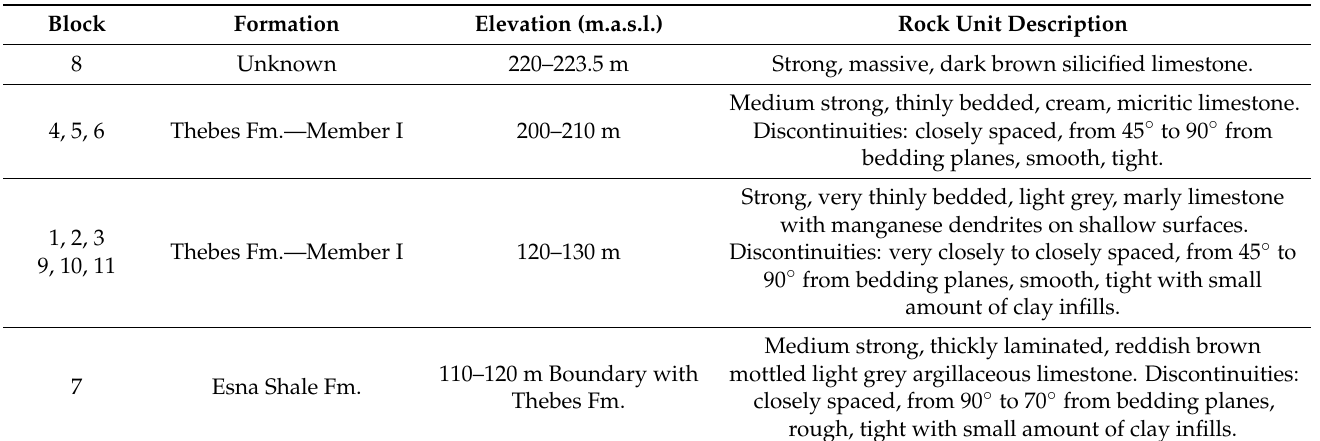
Table 2. List of blocks collected from the KV for the present work grouped by the rock units. Descriptions based on macroscopical